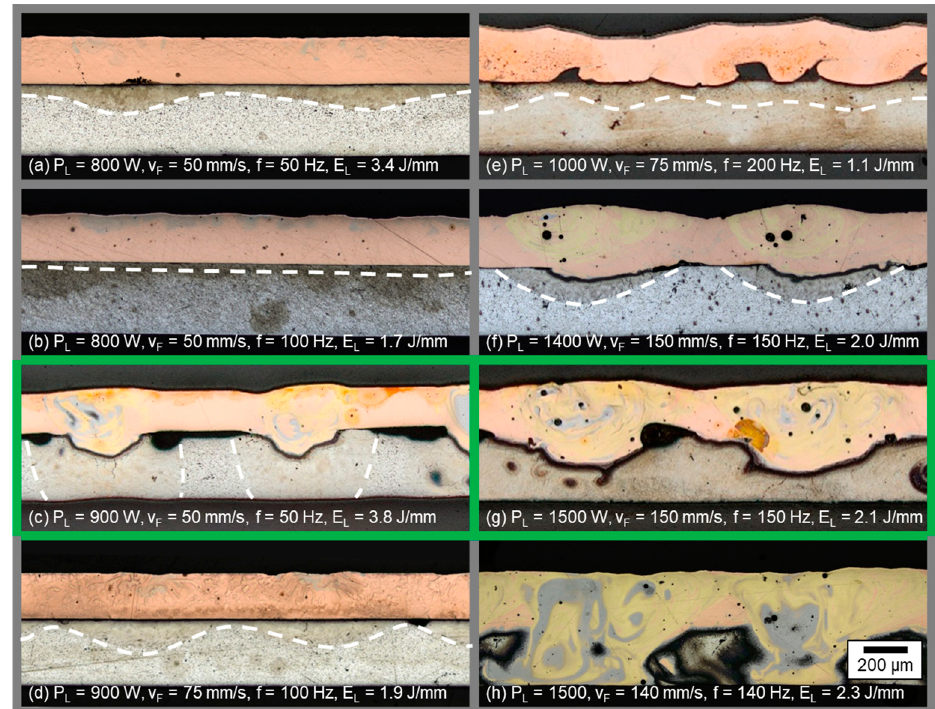
Figure 7. Longitudinal sections of welds produced with circular beam oscillation for different laser powers and feed parameters (v F, f); welding direction from left to right.